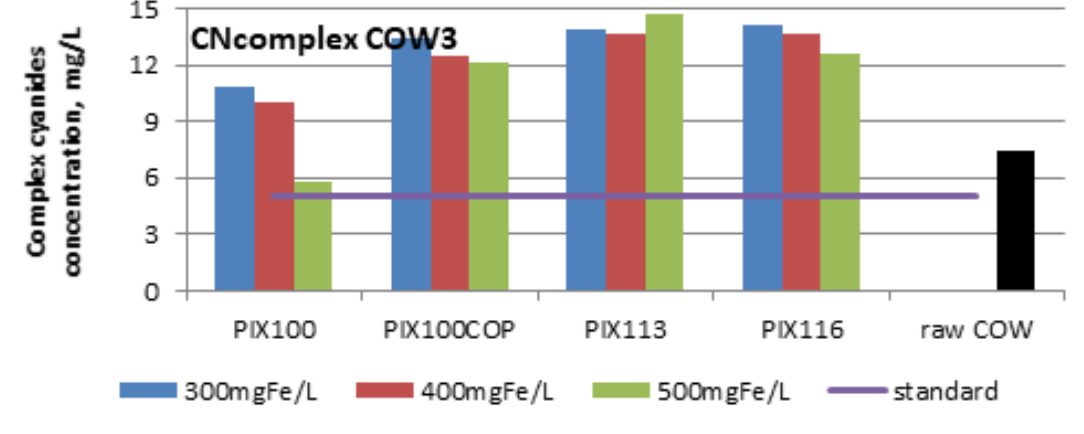
Figure 9: Final concentration of complex cyanides in COW3.